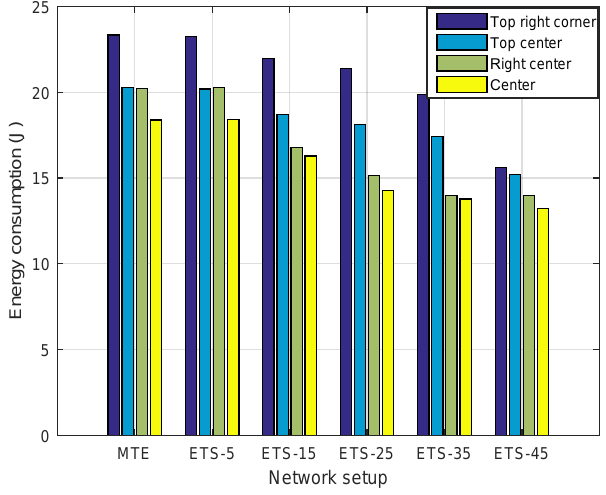
Figure 9. Energy consumption of different sink node